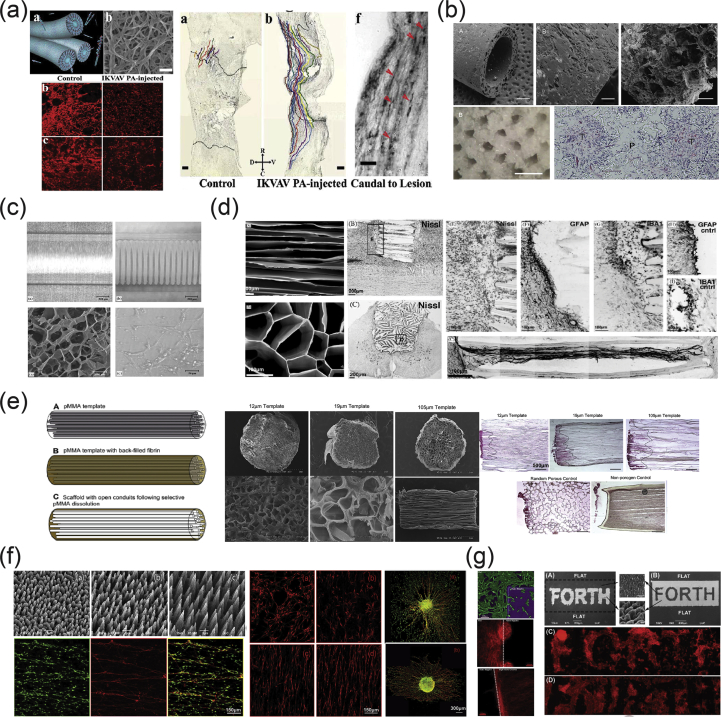
Conventional, porous, and molding methods for the creation of tissue engineering scaffolds for SC regeneration after injury. (a) Use of a self-assembling peptide amphiphile for the creation of a scaffold that was able to promote neurite outgrowth in a SC injury model [187], (b) NGF-loaded single-lumen and multiple lumen nerve conduits were fabricated using a combination of methods and remained intact for 13 days after implantation in vivo [188], (c) chitin and chitosan hydrogel tubes were produced by injection molding and were shown to induce neurite extension in chick DRG models [72], (d) freeze-dried agarose scaffolds were able to guide injured axon growth in in vivo models [46], (e) combined use of methods to create fibrin scaffolds showed that scaffold porosity could play a more important role than geometrical dimensions of the conduits [189], (f) discontinuous and anisotropic microconical structures created through femtosecond laser texturing were able to control the directional outgrowth of Schwann cells, sympathetic neurons, and DRG explants [190], and (g) creation of nanorippled and microgrooved hierarchical patterned surfaces showed that the combination of the two morphologies supports Schwann cell outgrowth [63]. Images adapted with permission from (a) Tysseling-Mattiace et al. ​[187] (Copyright (2008) Society for Neuroscience), (b) Yang et al. ​[78], (c) Freier et al. ​[72], (d) Stokols and Tuszynski [46], (e) Scott et al. ​[189], (f) Simitzi et al. ​[190], and (g) Yiannakou et al. ​[63]. DRG, dorsal root ganglion; NGF, nerve growth factor; SC, spinal cord; IKVAV, isoleucine-lysine-valine-alanine-valine; PA, peptide amphiphile.